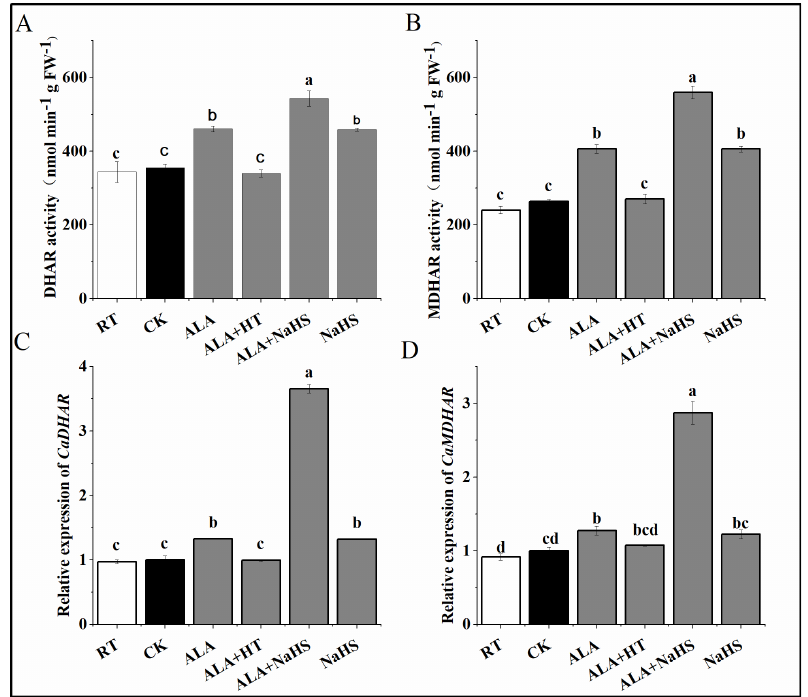
Figure 7. Effects of ALA and/or H 2 S on the activities of DHAR ( A ) and MDHAR ( B ) and the relative expressions of CaDHAR ( C ) and CaMDHAR ( D ) under chilling stress for 24 h. The error bars are the standard errors for three independent tests. Different letters show significant differences ( p < 0.05) based on Duncan’s test.